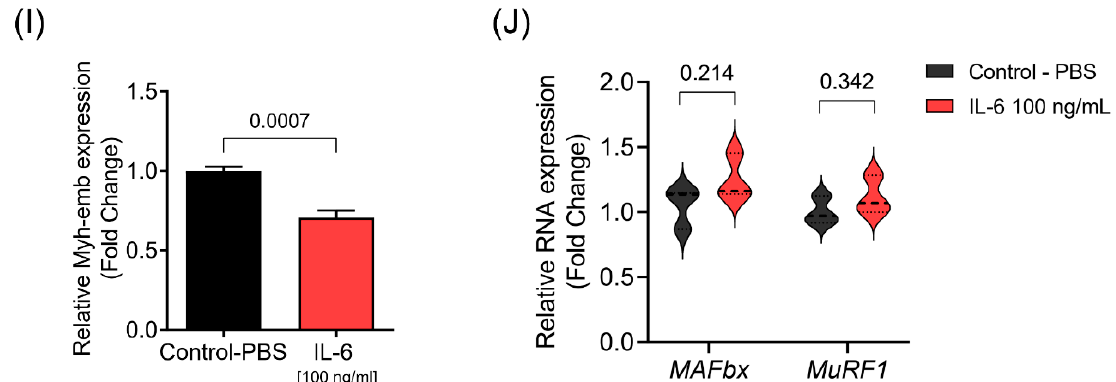
Figure 1. IL-6 induces C2C12 myotube atrophy. ( A – C ) IL-6 and Myh7 mRNA levels in differentiated C2C12 myotubes treated with three different concentrations of IL-6. RT-qPCR data are represented as fold change (2 ΔΔ Ct ) relative to Rpl13a . Data represent the average of three independent experiments with standard deviation. ( D – F ) Diameter of myotubes treated with IL-6 ( D , 10 ng/mL; E , 50 ng/mL; F , 100 ng/mL) myotubes with their corresponding controls. ( G ), Representative images of myotubes from both control and IL-6 treated (100 ng/mL) myotubes. Immunofluorescence was performed using the antibody against Myh2 and Dapi (4 (cid:48) ,6-Diamidine-2 (cid:48) -phenylindole dihydrochloride). ( H ) Quantitative analysis of the myotube area of control and IL-6 treated myotubes (100 ng/mL) myotubes. ( I ) mRNA levels of embryonic myosin (Myh-emb) and ( J ) mRNA levels of atrogenes MAFbx and MuRF1 in differentiated C2C12 myotubes treated with IL-6 (100 ng/mL). RT-qPCR data are presented as fold change (2 − ∆∆ Ct ) relative to Rpl13a . Statistical difference was analyzed by Student’s t